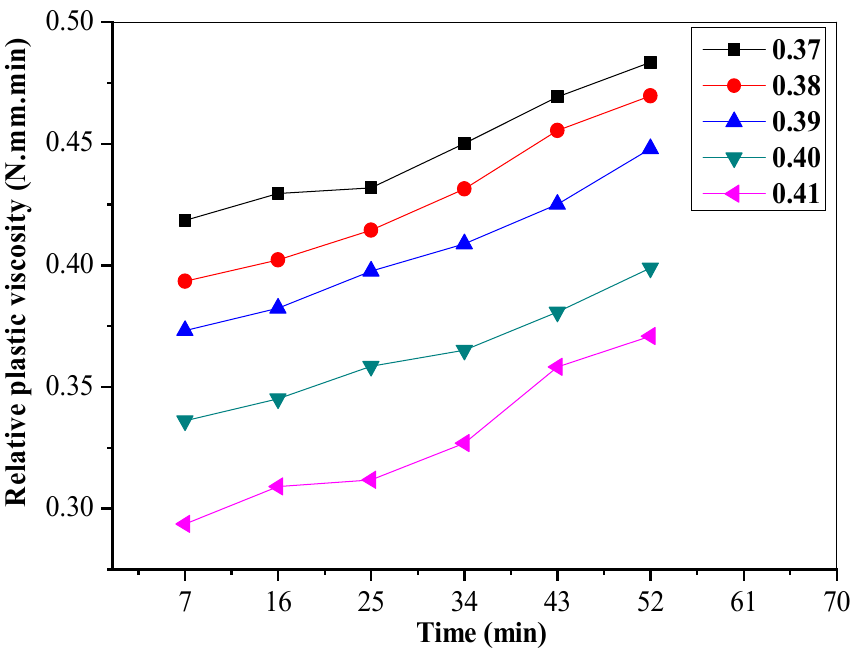
Figure 7. Relative plastic viscosity versus time. Applying the analysis of variance (ANOVA) to the results of relative plastic viscosity, one can find the forecast model described by Equation (8), which represents 99% of the cases. A graphical view of the variation of the plastic viscosity over time with the change of the A/P ratio is shown in Figure 8. Here, it is possible to easily observe the decrease in plastic viscosity with the increase in the A/P ratio and its growth over time.